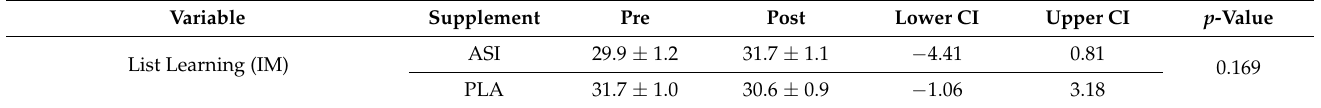
Table 2. RBANS subtest raw scores and Digital cognitive test